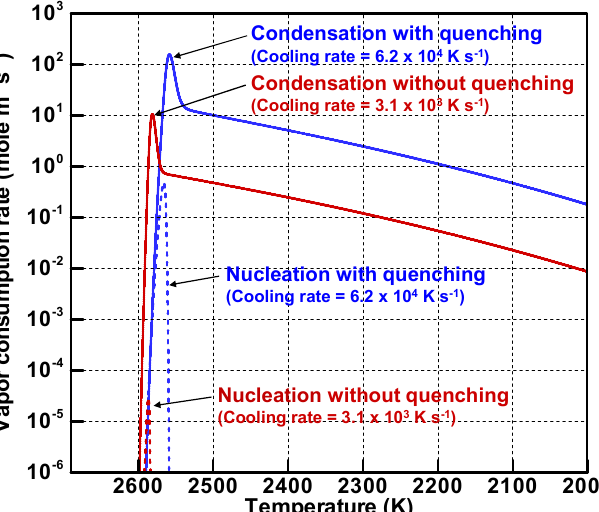
Figure 8. Evolutions of vapor consumption rates by homogeneous nucleation and heterogeneous condensation.